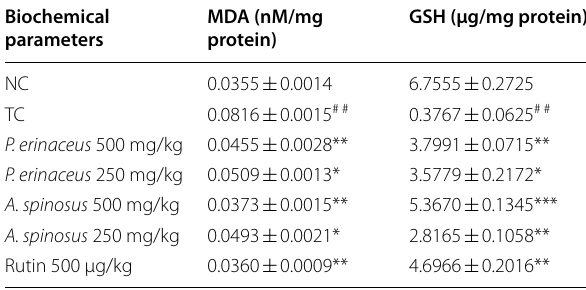
Table 2 Biochemical parameters in kidney